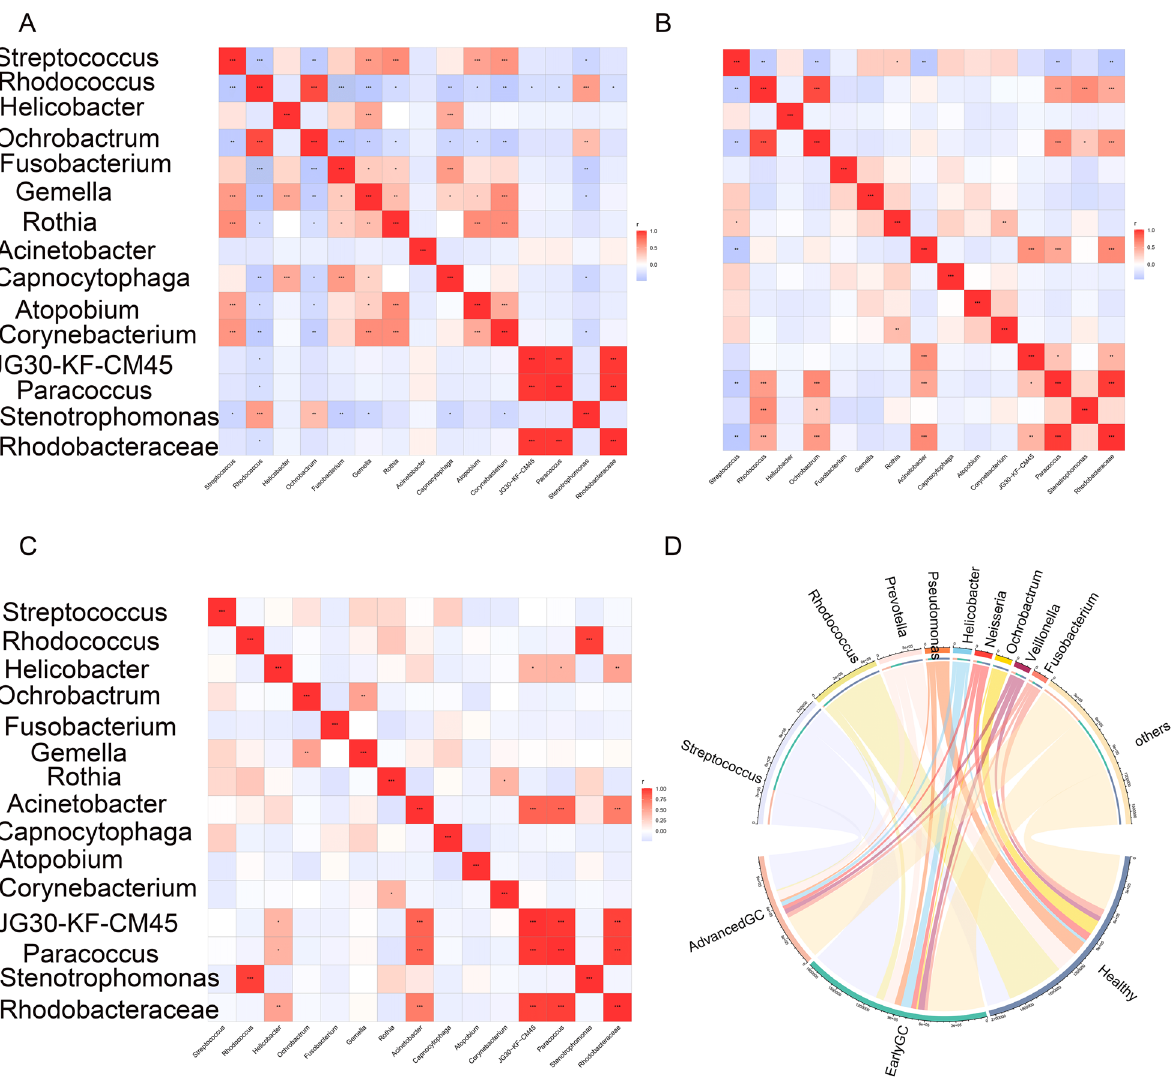
Fig. 7 Correlation analysis of different bacteria within and among three groups. A Intragroup bacterial correlation heatmap of the healthy group. The Pearson coefficient was used to calculate the correlation between the bacteria. The shade of color indicates the size of the data value. Pearson correlation coefficients are indicated in the figure. *0.01 < p < 0.05; **0.001 < p ≤ 0.01; ***p ≤ 0.001. B Intragroup bacterial cor- relation heatmap of the early GC group. C Intragroup bacterial correlation heatmap of the advanced GC group. D Chord diagram. One side of the circle is the species name, and the other side is the sample name, which is represented by different colors. The species abundance is displayed as a